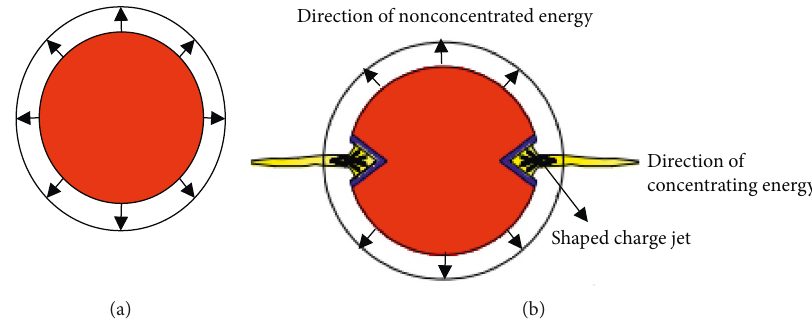
Figure 1: The principle of blasting: (a) conventional blasting; (b) cumulative blasting.